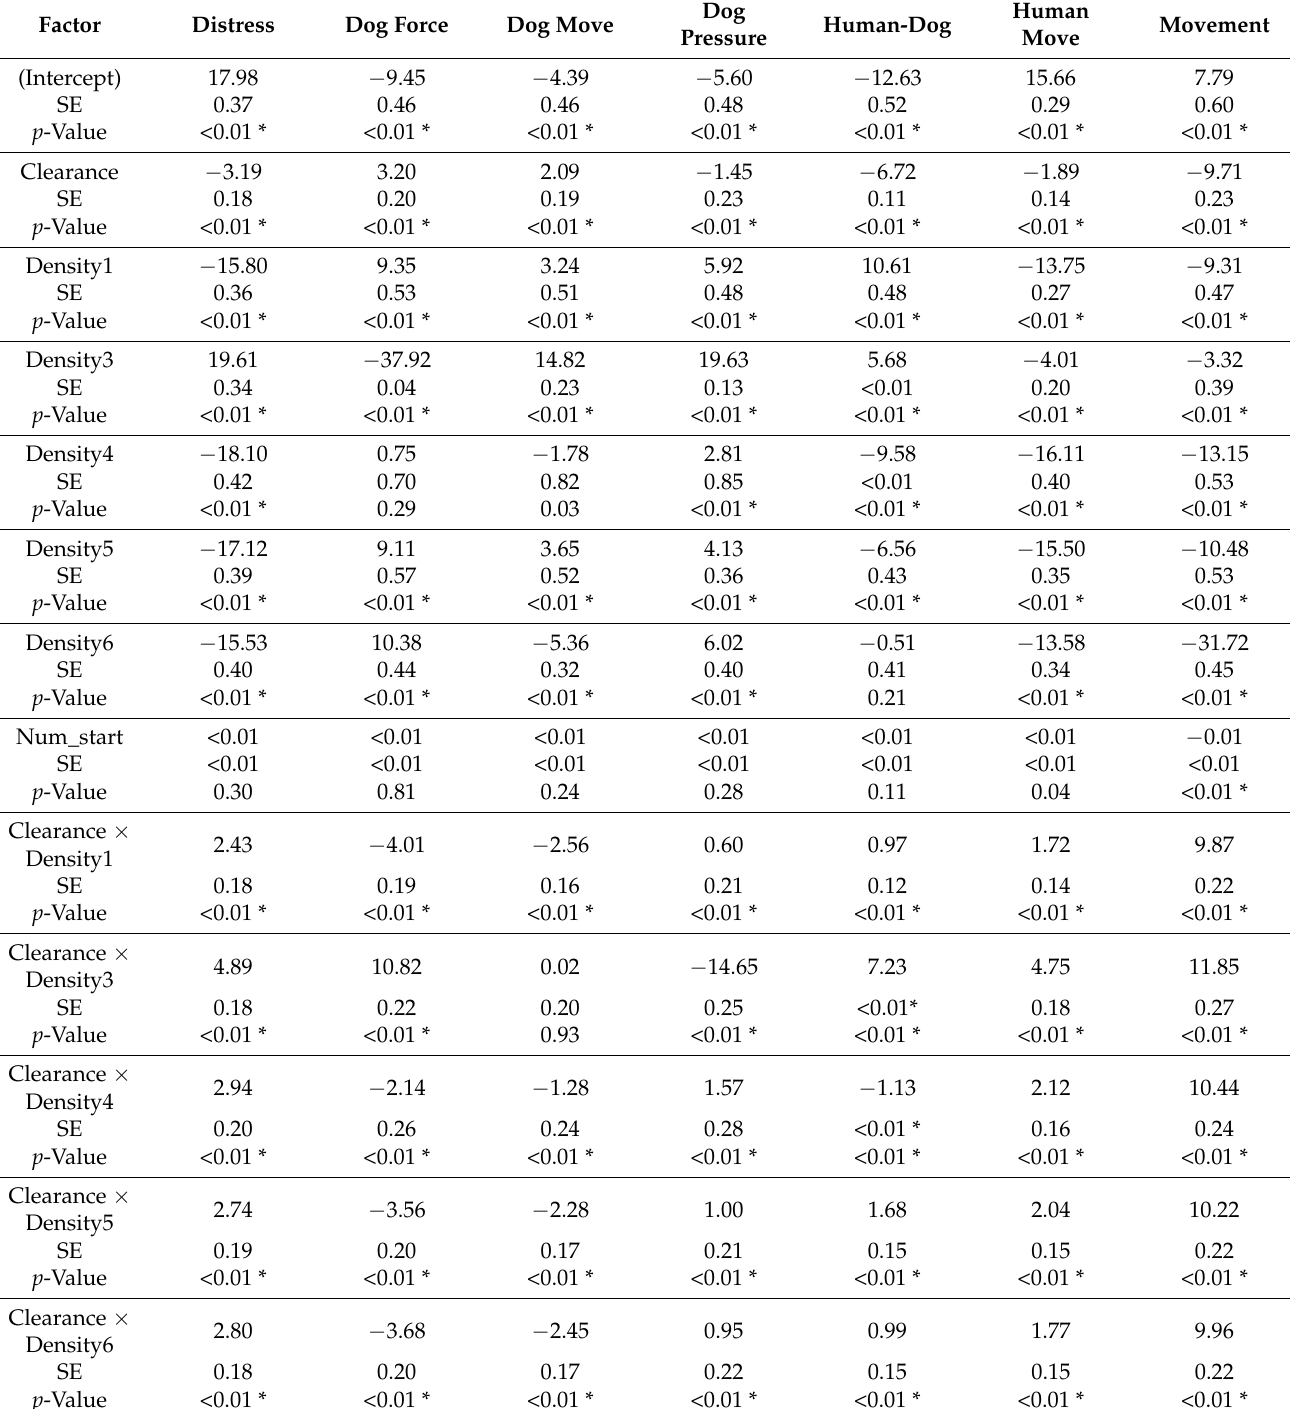
Table 5. Selected results from the multinomial model examining factors influencing behaviour category. See Table S1 for full results. Reference category is Density = 2 (free). “*” represents statistically significant